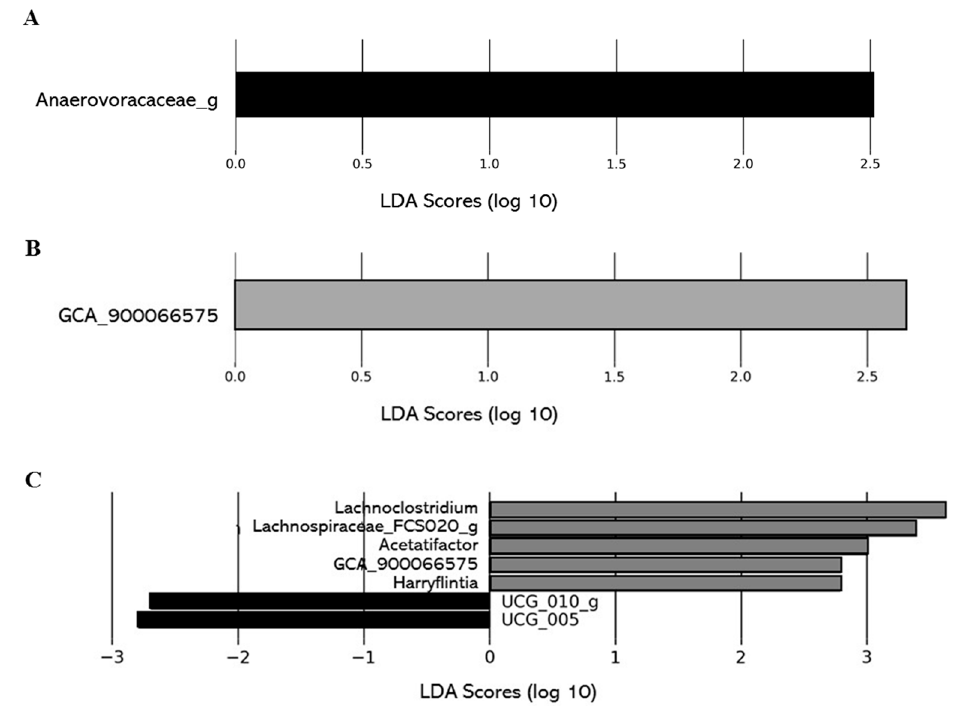
Figure 6. Level of deacidification of CJ is associated with changes in the gut microbial of mice. The linear discriminant analysis (LDA) effect size was calculated in order to explore the taxa within genus levels that more strongly discriminated between the gut microbiota of mice treated with ( A ) 0% DCJ (dark) and 40% DCJ (light grey), ( B ) 0% DCJ and 60% DCJ (medium grey), and ( C ) 0% DCJ and 80% DCJ (dark grey). Families followed by the label ‘-g’ indicate unidentified genera.